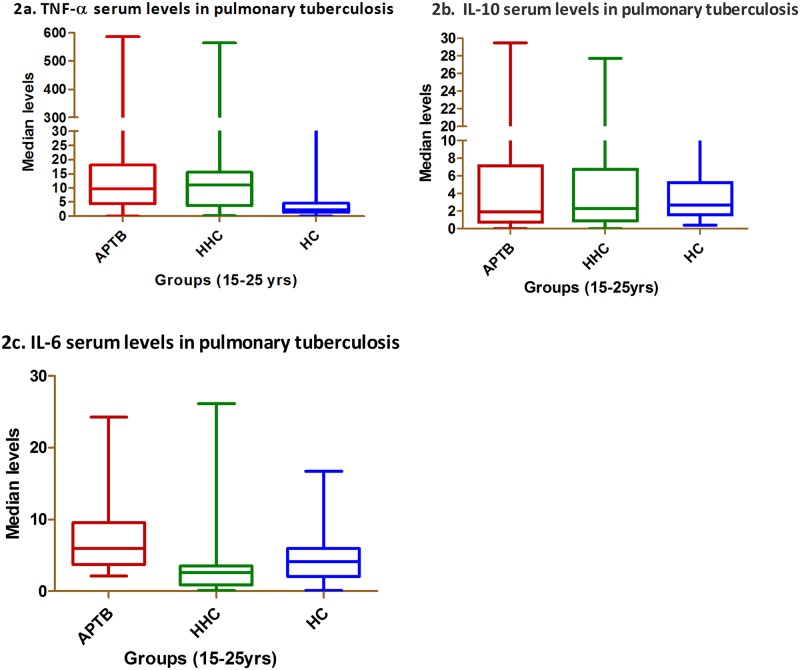
Serum levels of TNF-α, IL-10, IL-6.(2a, 2b, 2c) Data are shown as box plots, where the boxes represent the first through third quartiles, the lines within the boxes represent the median, and the lines outside the boxes represent the minimum and maximum values (excluding outliers). APTB- active pulmonary Tuberculosis patients; HHC-household contacts; HC-healthy controls.